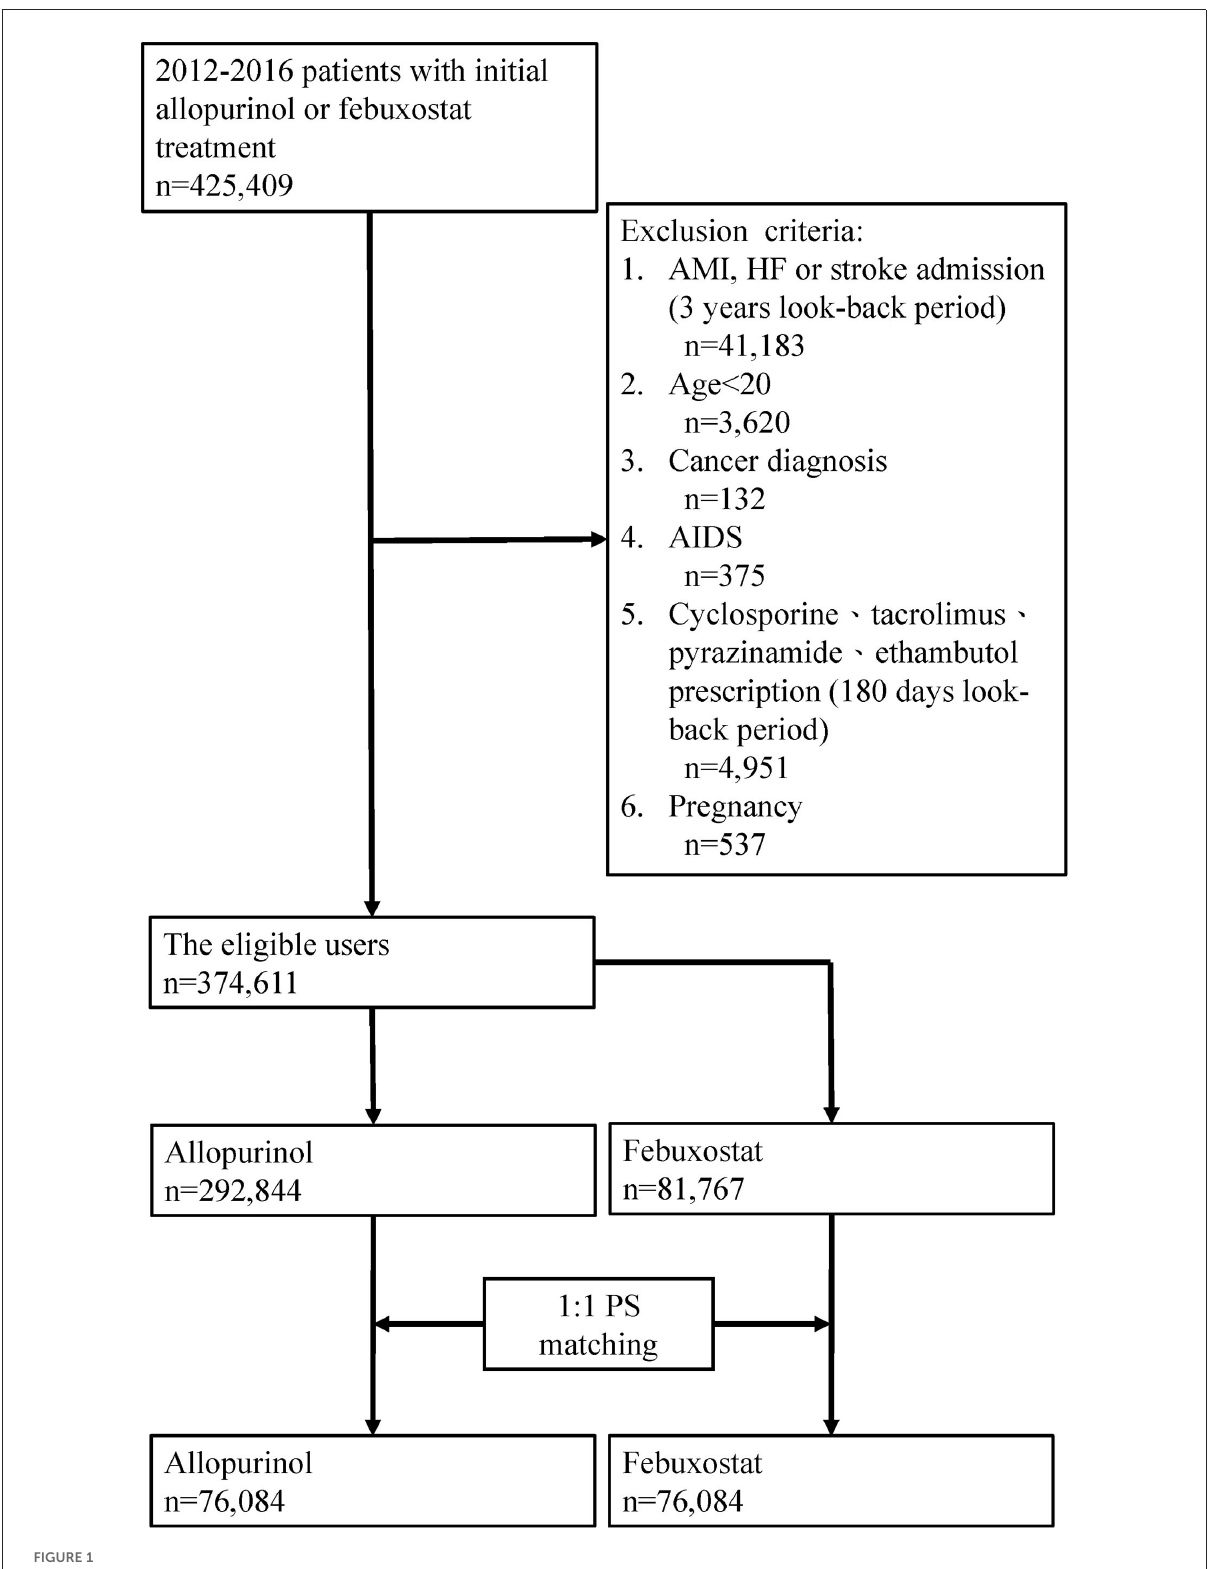
FIGURE1 Assembly of the study